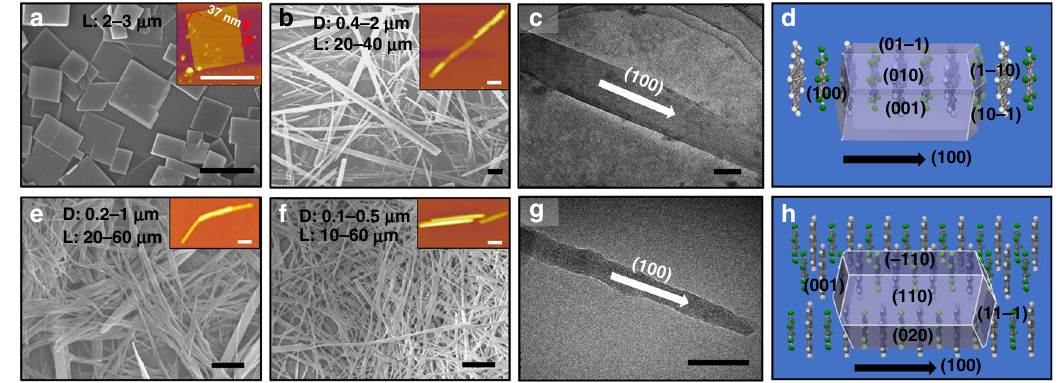
Fig. 2 Morphologies characterizations of the micro/nanocrystals. Per MS ( a ), Per/OFN MW ( b , c, d ), Cor MW ( e ), and Cor/OFN MW ( f , g , h ). a , b , e , f Low-magni fi cation SEM images of the four crystals, in which D and L denote the diameter and length, respectively. The insets are the corresponding AFM images, the height pro fi le is given in inset of ( a ). c , g Low-magni fi cation TEM images. d , h The predicted growth morphologies of the Per/OFN and Cor/ OFN cocrystals based on the calculated energies. The scale bars in a , b , e , f are 3 μ m, the scale bars in c , g are 500 nm